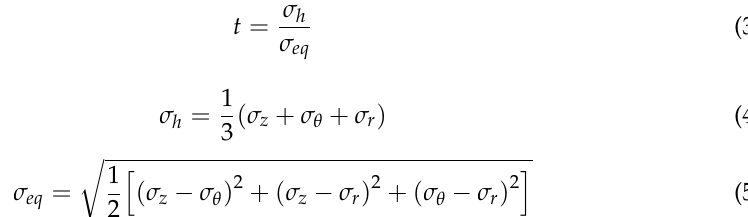
Figure 16. Stress distribution of σ ( left ) and σ θ ( right ) along the transversal necking surface in steel E0 and E7. z Once the distribution of stresses along the minimum neck section is known, and Figure 17 (left) shows that the values of hydrostatic and equivalent stresses are higher considering that the shear stresses are null by symmetry, it is possible to obtain the stress for the case of prestressing steel (E7) in relation to the initial hot rolled bar (E0). The σ h triaxiality distribution along the radius r of the neck section. The stress triaxiality t (3) is distribution shows a continuous decrement from the longitudinal wire axis ( r = 0) till it the ratio between the hydrostatic stress σ (4) and the equivalent von Mises stress σ (5). reaches the external surface ( r = a ); that being said, the decrement is more pronounced in h eq the prestressing steel E7. The equivalent von Mises stress σ eq is constant along the radial coordinate for both eq